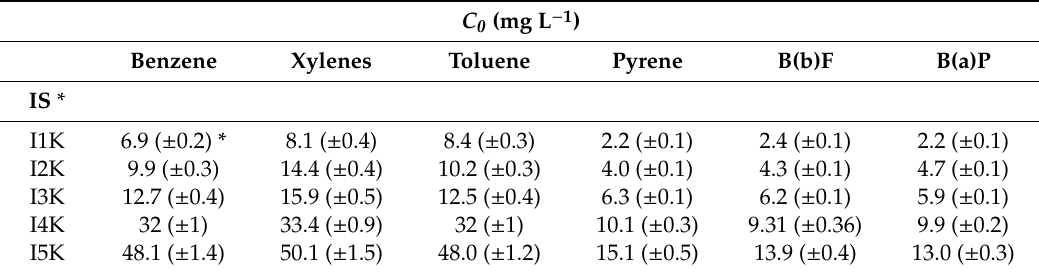
Table 1. Concentration of the di ff erent adsorbates in the solutions used for sorption kinetics experiments **